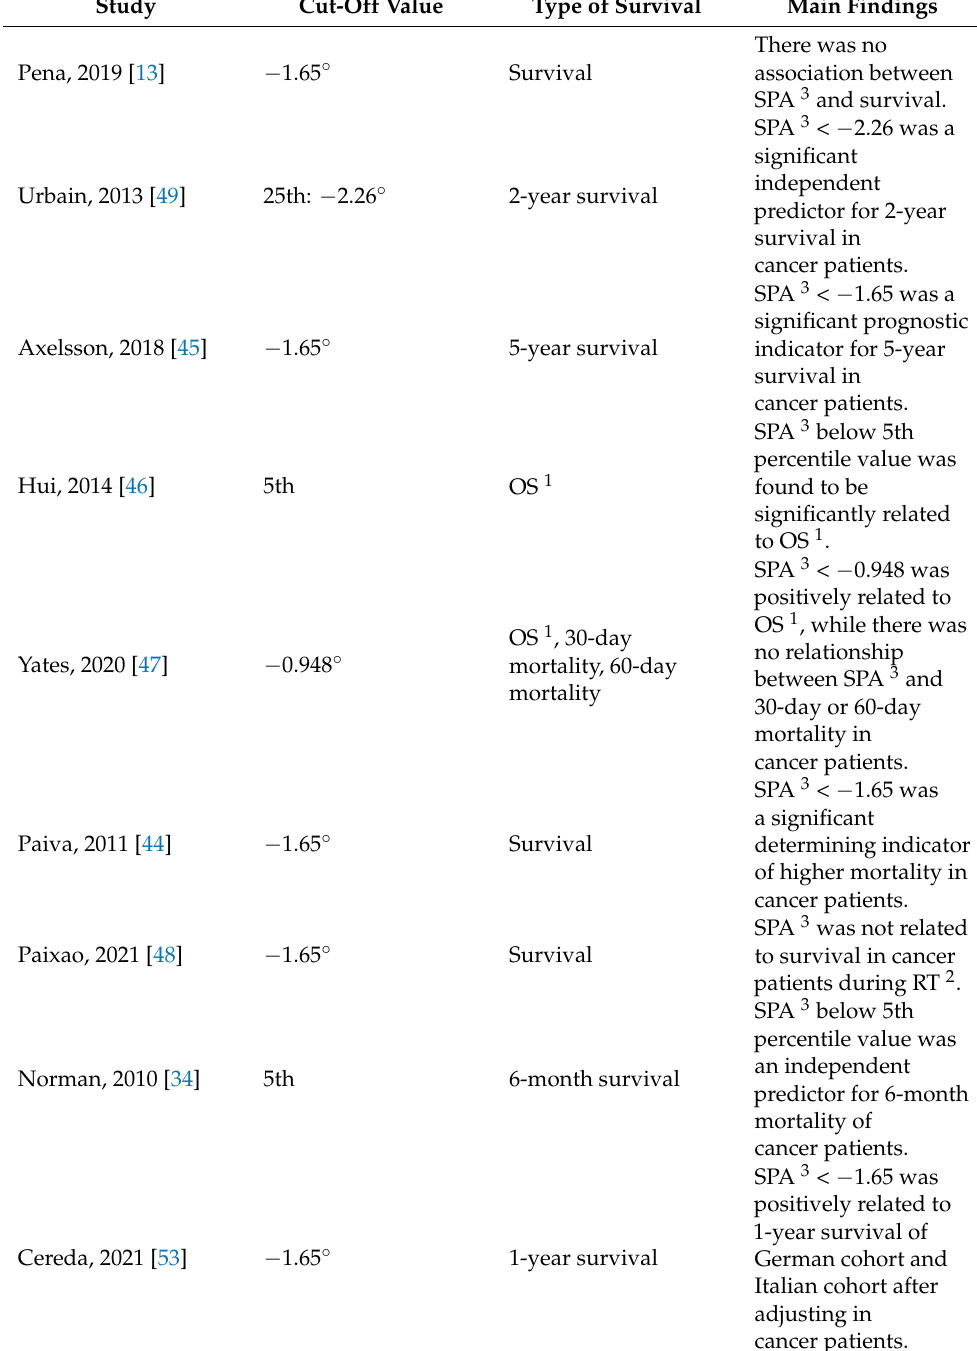
Table 6. Relationship between SPA and